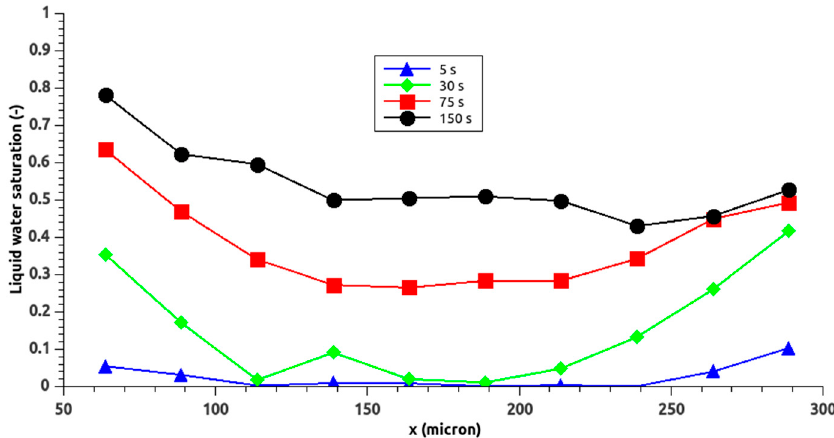
Figure 7. Cross-sectional averaged distributions of liquid water saturation along the through-plane direction in the GDL at different time instants in case 1.